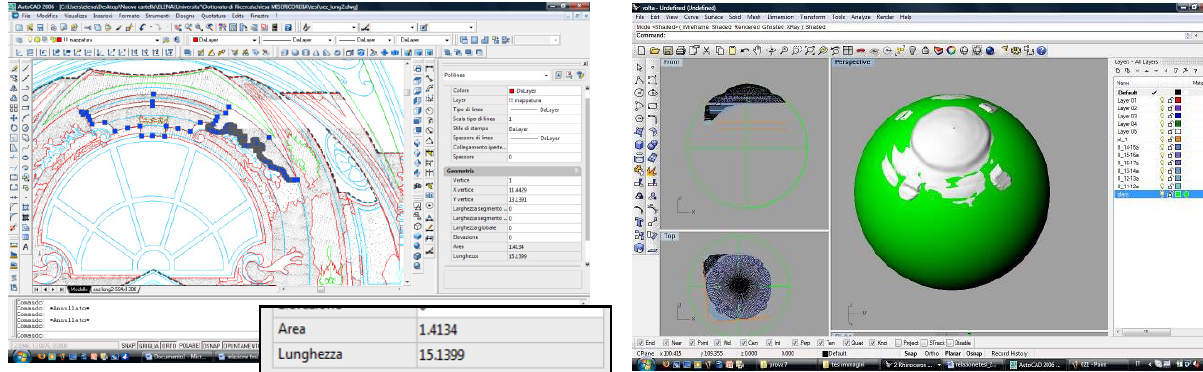
Figure 12 - Model we started from the point cloud which was followed by their